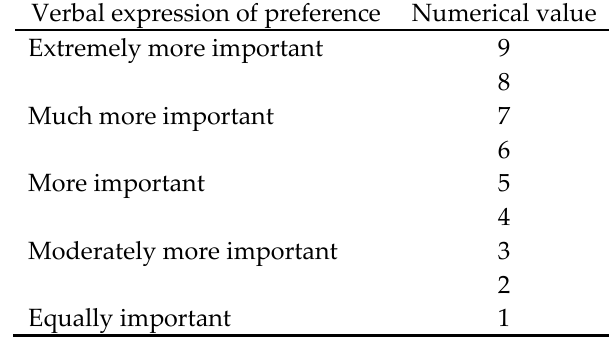
Figure 3. Verbal scale of preferences.